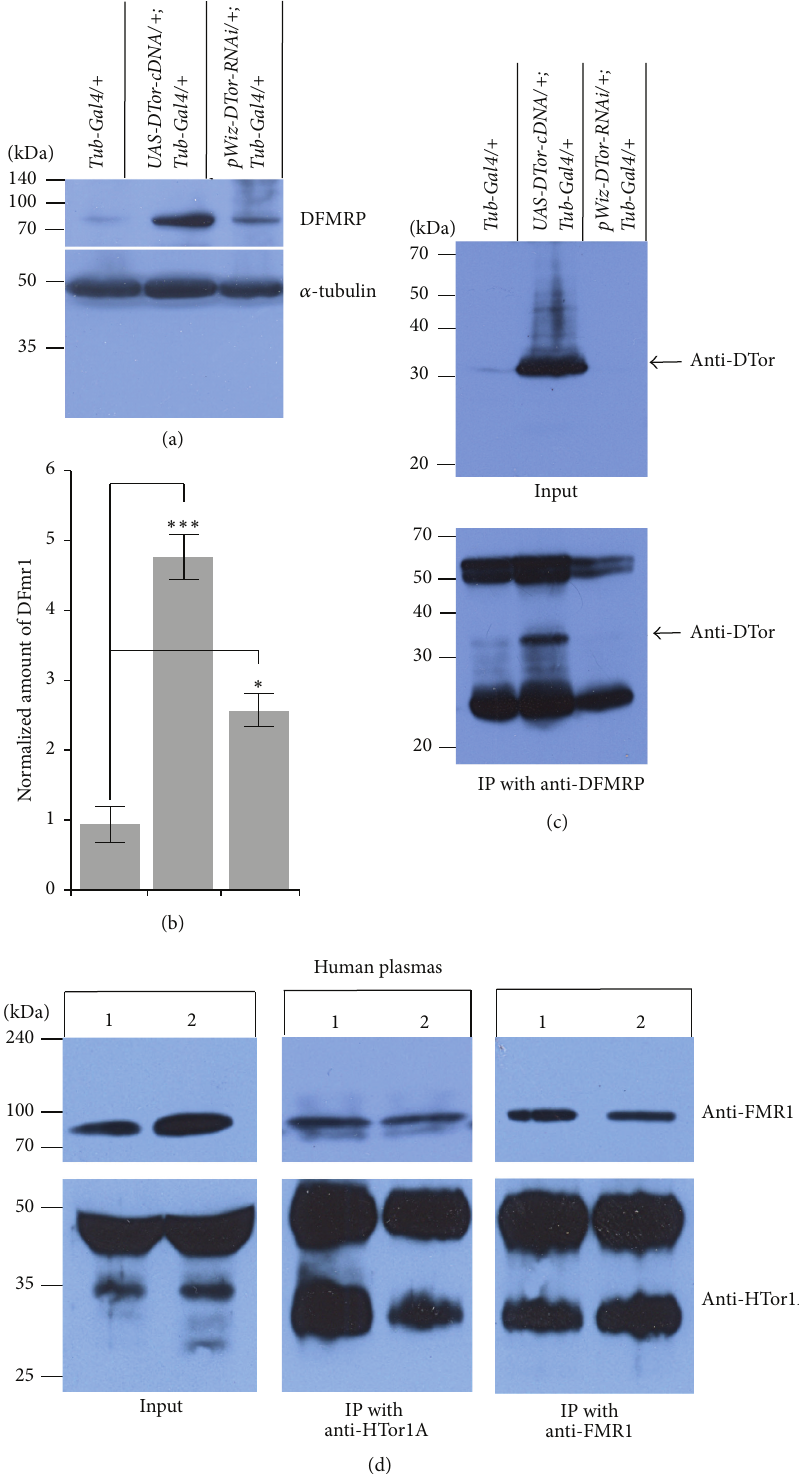
Figure 8: Torsin proteins existed in the same protein complexes as Fragile-mental retardation proteins in Drosophila brains and human blood plasma. (a) The expression of DFMRP proteins was altered in DTor-cDNA or DTor-RNAi-expressing brains. (b) Quantification of DFMRP proteins in control and DTor-cDNA or DTor-RNAi-expressing brains. (c) DTor and DFMRP proteins exist in the same protein complexes. (d) Human FMR1 and HTor1A proteins are present in the same protein complexes. ∗ 𝑝 < 0.05. ∗∗∗ 𝑝 <